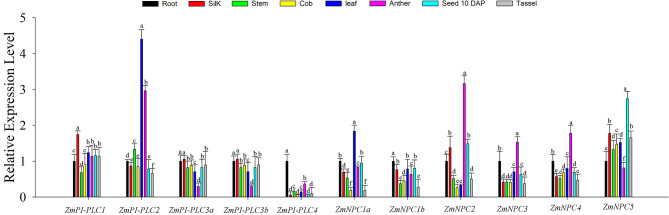
Tissue-specific expression patterns of the 11 ZmPLC genes in maize root, stem, leaf, silk, immature cob, anther, and kernel [10 days after pollination (DAP)] by using qRT-PCR. The expression levels were normalized to that of TUB. Bars represent SE (n = 3). The entire experiment was repeated three times. Different letters indicate values that departed significantly from those of root.